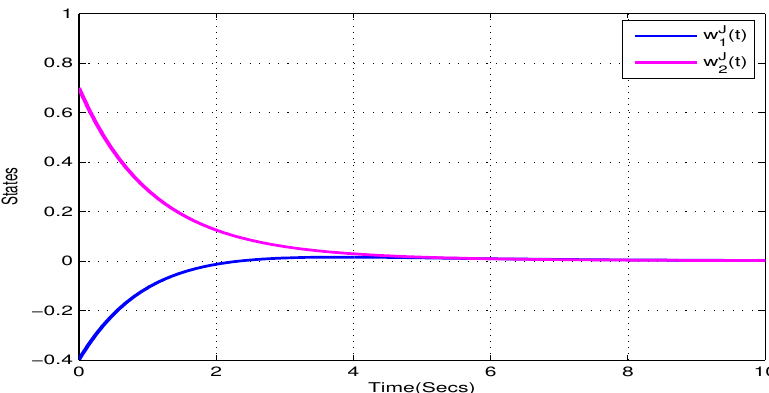
( t ) of systems (23) with state feedback control u ( t ) , w J 2 1